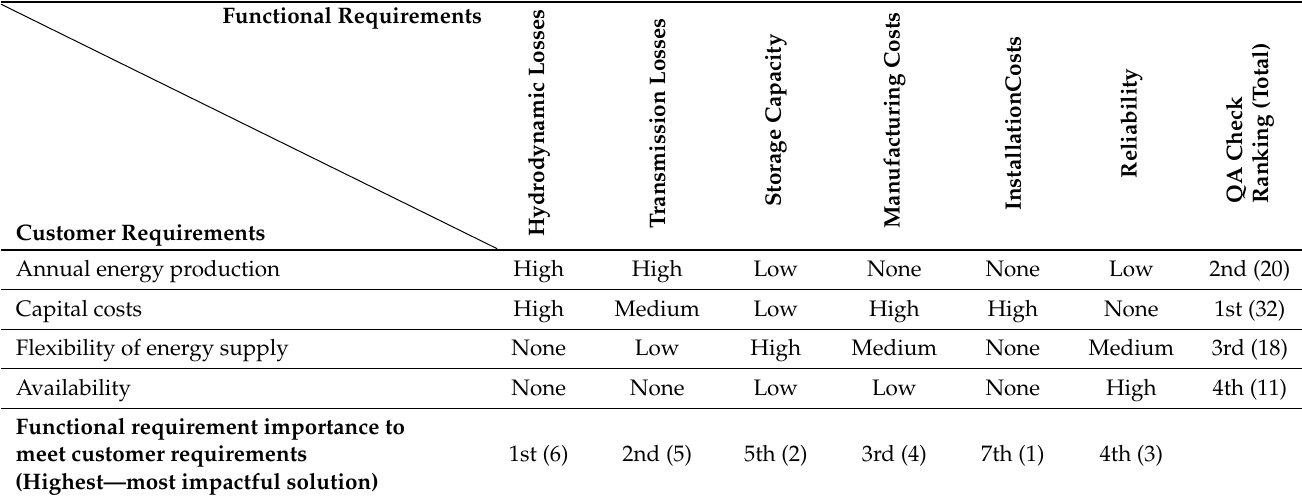
Table 3. Example of defined functional requirements and relationships between the customer and functional requirements. The number and wording of functional and customer requirements are determined by those completing the methodology.